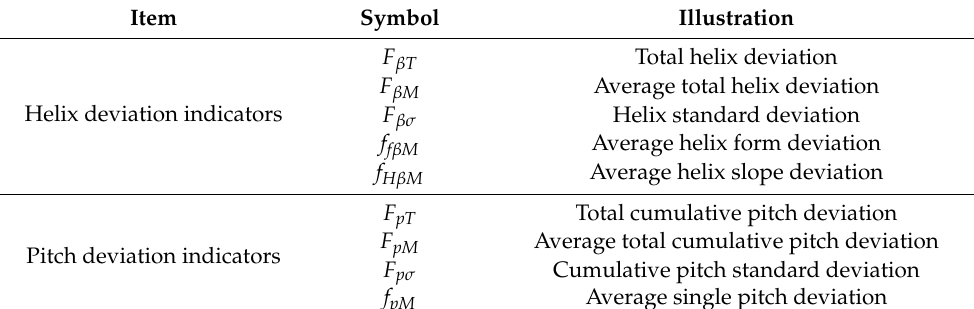
Table 1. Assessment indicators for helix and pitch